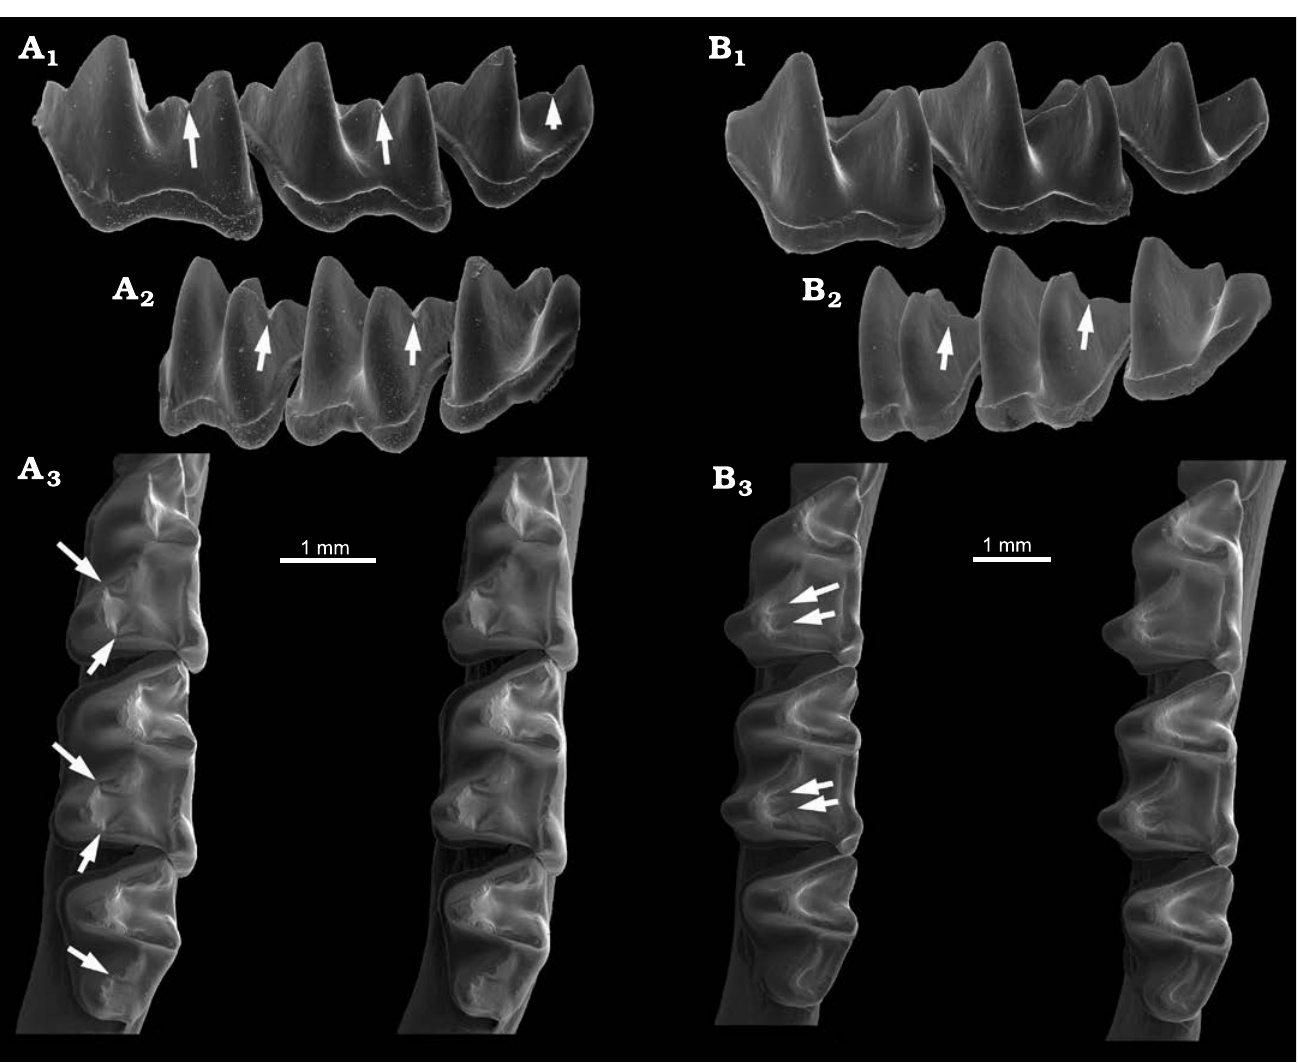
Fig. 8. Lower molars of Recent phyllostomid bats. A . Lophostoma silvicolum D’Orbigny, 1836, (USNM 335113) from Panama. Lower molars in antero- labial view (A 1 ), showing deep carnassiform notches in the cristids obliqua of m1–m2 and a weaker notch in m3 (arrows); in posterolabial view (A 2 ), showing deep carnassiform notches in the postcristids of m1–m2 (arrows); in occlusal view (A 3 , stereopair), showing notches and associated accessory troughs in the talonid basins (arrows). B . Phyllostomus elongatus (Geoffroy, 1810) (USNM 388796) from Venezuela. Lower molars in anterolabial view (B 1 ), showing absent to incipient cristid obliqua notches on m1–m2; posterolabial view (B 2 ), showing weak carnassiform notches on the postcristids in m1–m2 (arrows); occlusal view (B 3 , stereopair), showing the deep accessory troughs adjacent to both the cristids obliqua and postcristids in the talonid basins of m1–m2